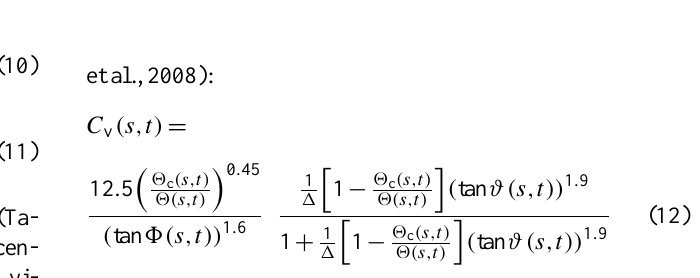
Fig. 8. Evolution in time of embankment profiles. For a generic profile, the first section, s 0 , the last one, s L , and some intermediate sections, s j , are shown.